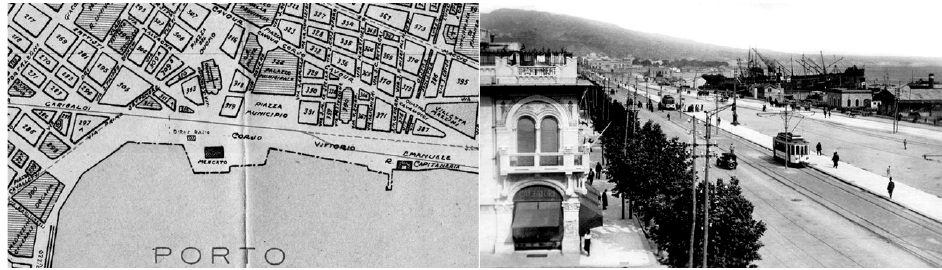
Figure 3. The seafront in the 1920s: the ban on rebuilding the Palazzata. Author processing/Private collection.